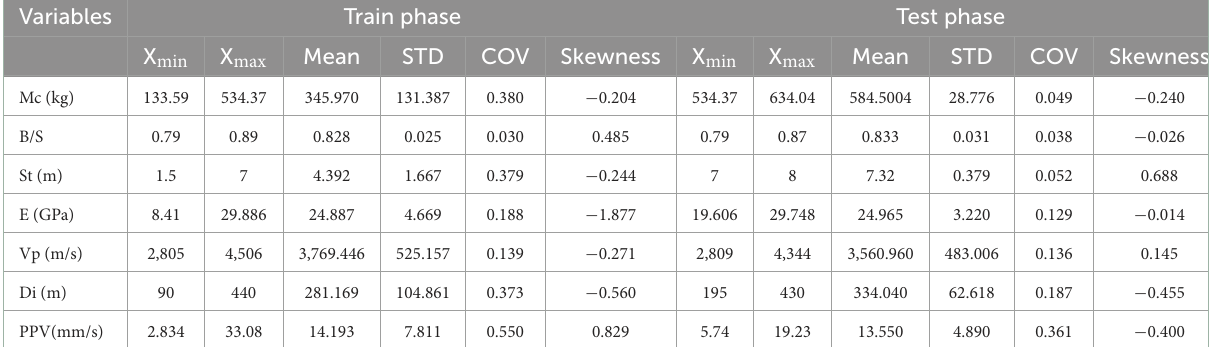
TABLE 2 Statistical characteristics of data sets.